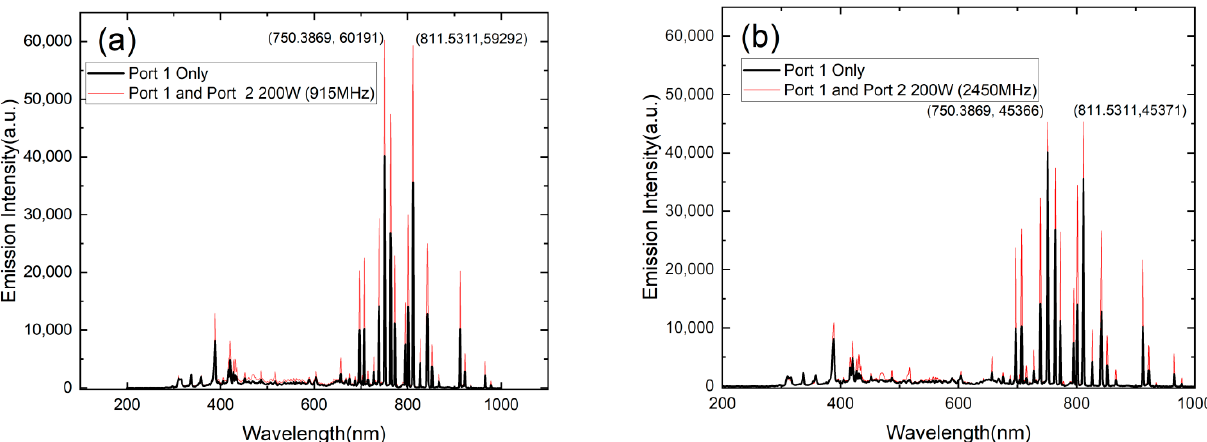
Figure 5. Spectrum of microwave inputted from Port 2 at the power of 200 W: ( a ) 915 MHz microwave; ( b ) 2450 MHz microwave.